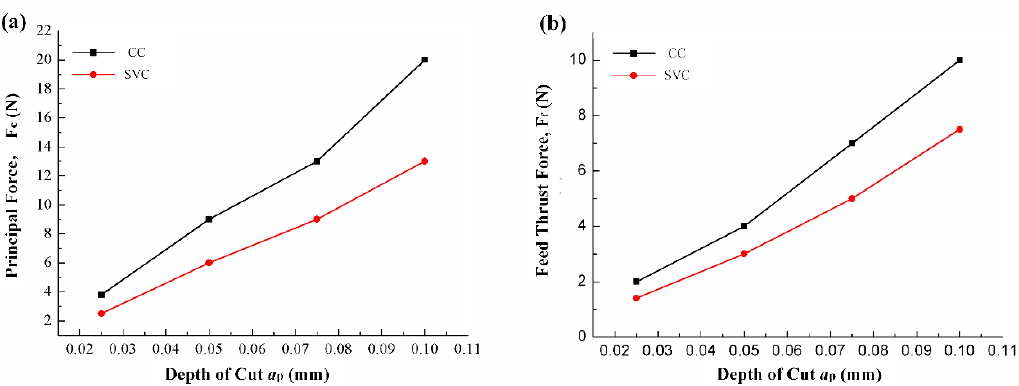
Figure 7. Average ( a ) principal and ( b ) feed thrust forces vs. depth of cut (feed rate, 0.005 mm/r; cutting speed, 200 m/min).